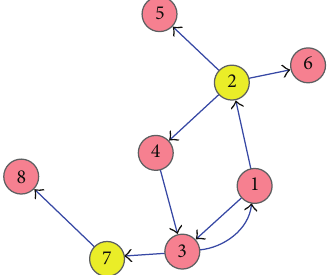
Figure 1: A simple directed network with 3 suspension nodes and 2